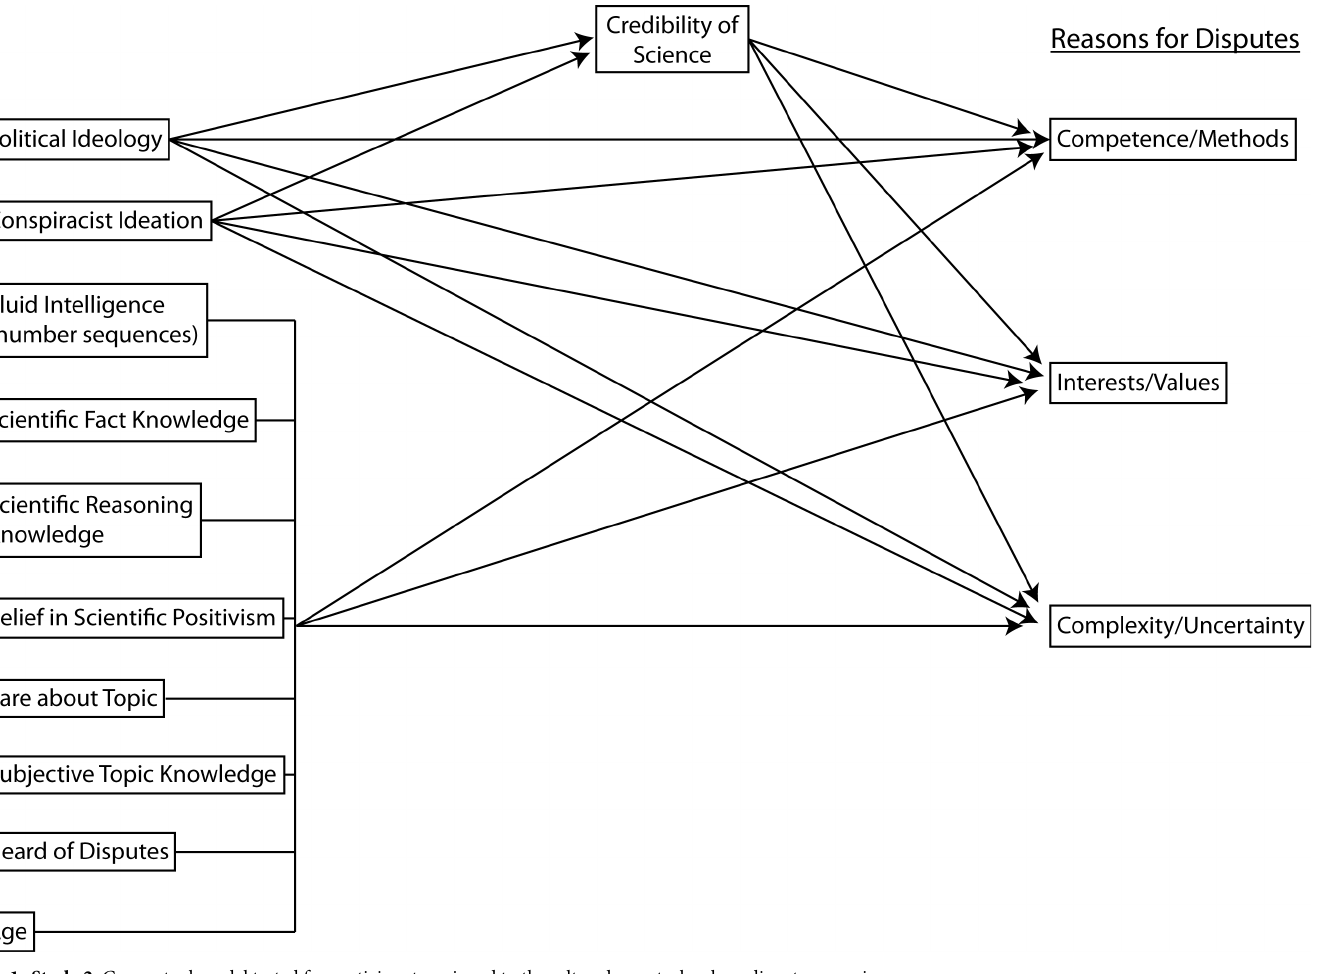
PLOS ONE | https://doi.org/10.1371/journal.pone.0211269 February 7,